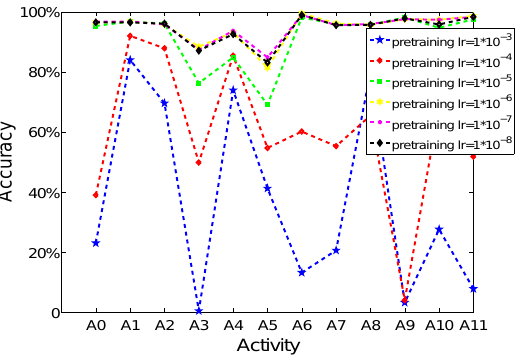
Figure 5. The recognition performance of each activity when using different pretraining learning rates (iterations is set to 200; number of hidden layer is set to 2; fine-tuning learning rate is set to 0.01).